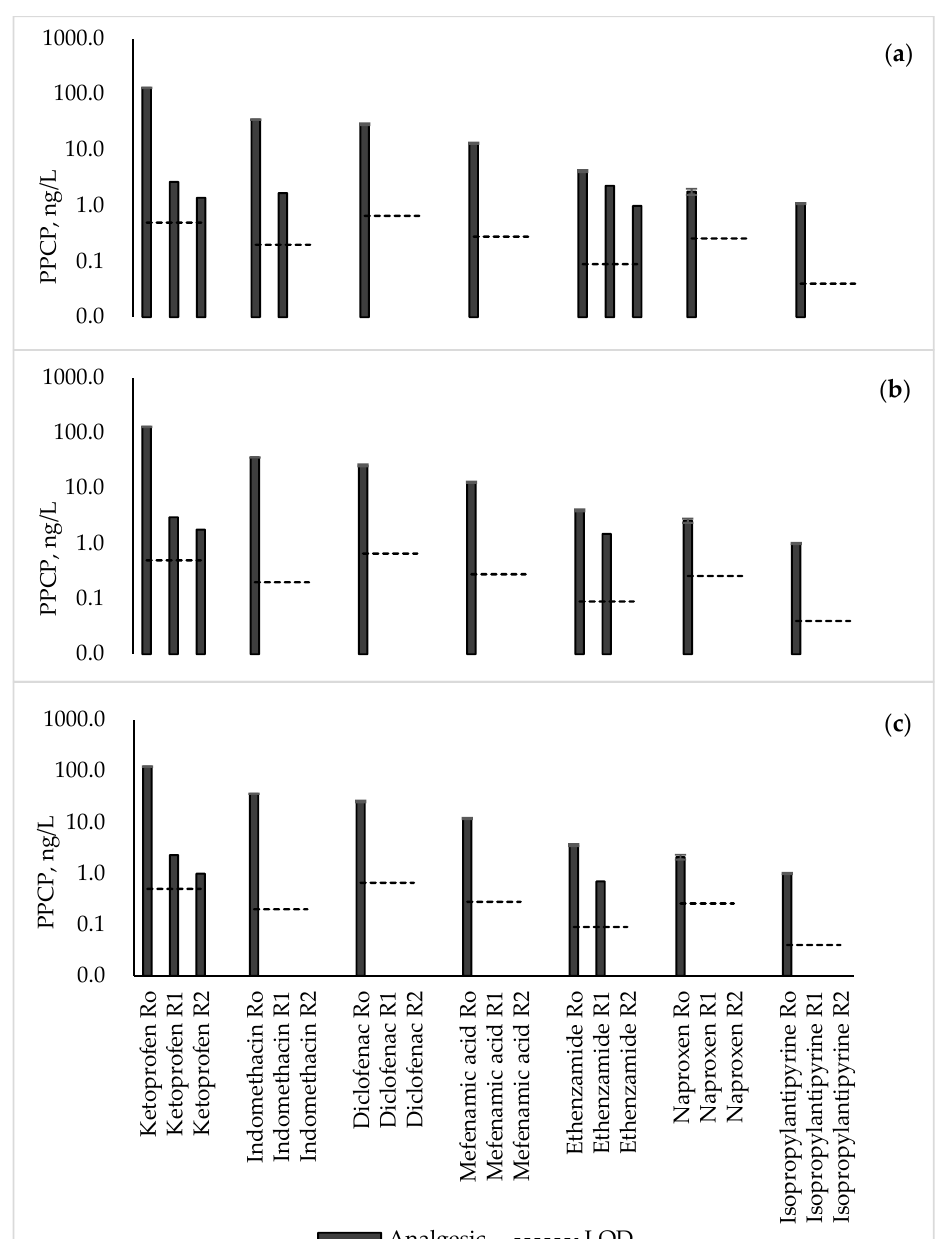
Figure 3. Concentrations of seven analgesics in the feed secondary effluent (R o ) and effluent of the R 1 and R 2 reactors at the O 3 doses of: ( a ) 1 and 2 mg L − 1 , respectively, in Run 1; ( b ) 2 and 4 mg L − 1 , respectively, in Run 2; and ( c ) 3 and 6 mg L − 1 , respectively, in Run 3.